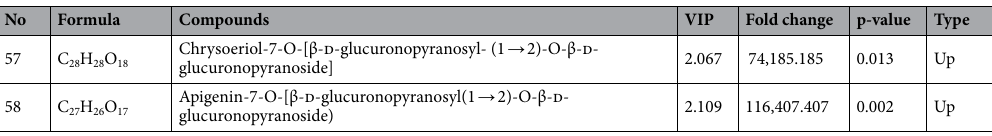
Table 2. DMs from 228 SMs. Up: compared with ZP, the corresponding metabolite was up-regulated in YS. Down: compared with ZP, the corresponding metabolite was down-regulated in YS.